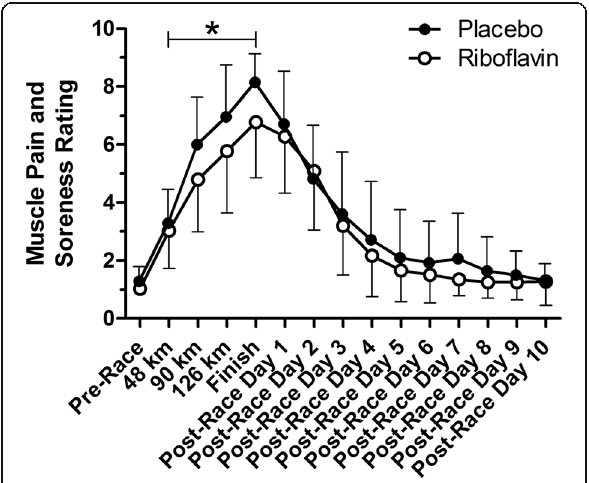
Table 1 Selected characteristics of the two study groups Characteristic